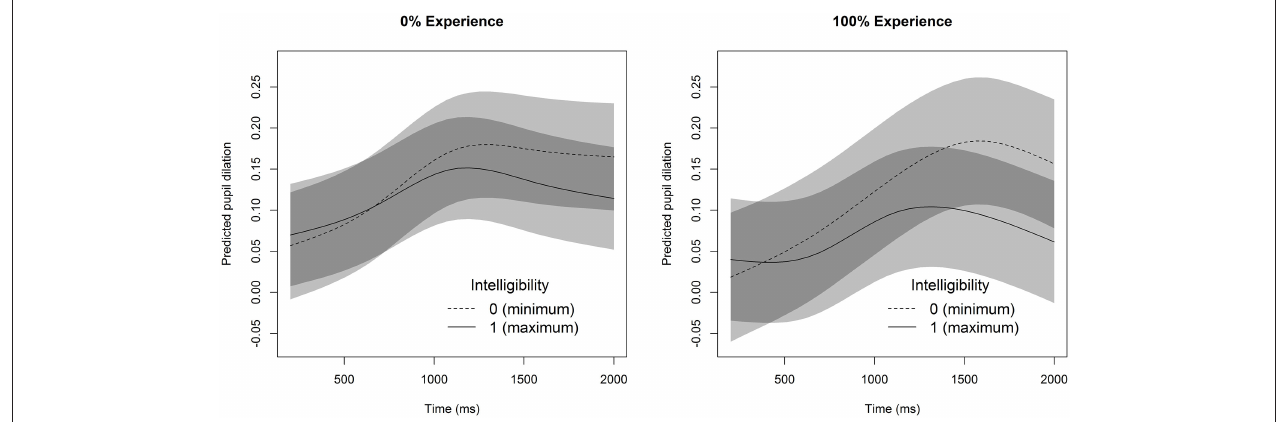
FIGURE 4 | Time-course plots of pupil dilation values predicted by the model for minimum experience (left panel) and maximum experience (right panel), each comparing completely unintelligible and fully intelligible stimuli. Shaded bands indicate 95% confidence